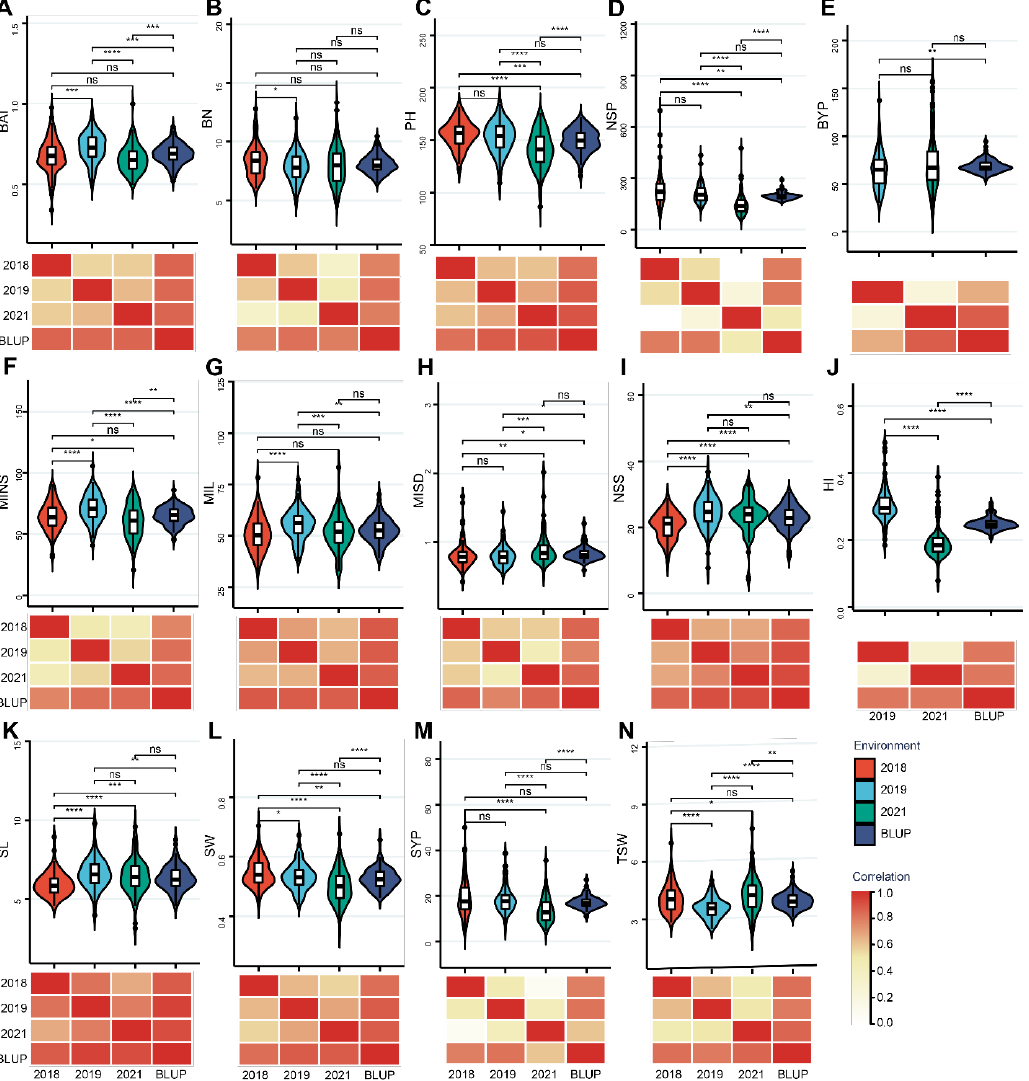
Figure 1. Phenotypic analysis for HI and HI-related traits. Upper parts of ( A – N ) are statistical analyses of the respective test traits. The violin plots display the distribution patterns of phenotypic values. The width of the violin plot represents the density of the distribution. The black horizontal line in the box plot shows the median value, and the upper and lower boxes in the box represent the upper and lower quartiles of the data set. Statistical significance is determined by the Wilcoxon test. *, **, ***, and **** represent significant at 0.05, 0.01, 0.001, and 0.0001, and ns is short for no significance. Lower parts of ( A – N ) show the relationships among the respective environments. The redder the color, the stronger the correlation. BN, numbers of primary valid branch; BAI, branch angle index; BYP, biomass yield per plant; HI, harvest index; MIL, main inflorescence length; MINS, number of effective siliques on main inflorescence; MISD, silique density of the main inflorescence; NSP, number of siliques per plant; NSS, number of seeds per silique; PH, plant height; SL, silique length; SW, silique width; SYP, seed yield per plant; TSW, thousand-seed weight. We measured the three-part branch angles (BA) for each plant including TBA, MBA, and BBA. However, there were large differences between the angles of different parts, and